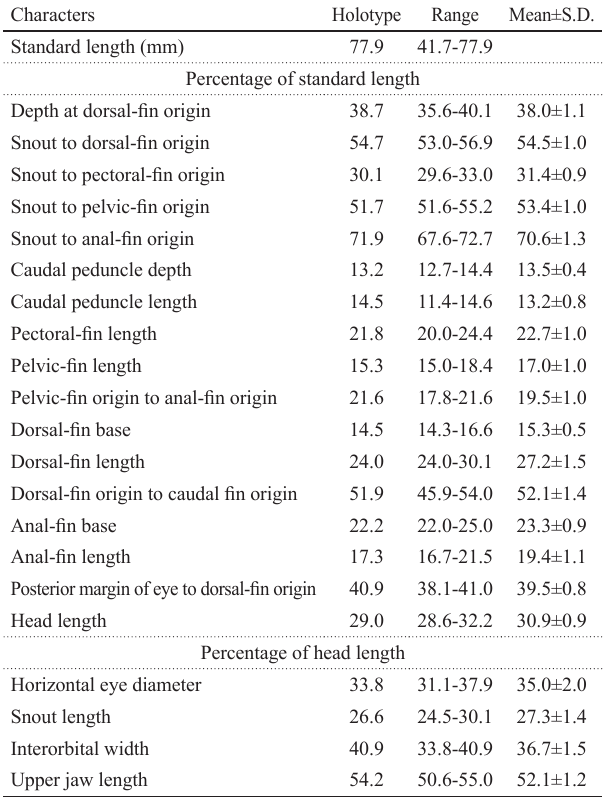
Table 1 . Morphometric data of the holotype and paratypes of Moenkhausia parecis . Paratype range includes the values of the holotype. N = 30; S.D. = Standard